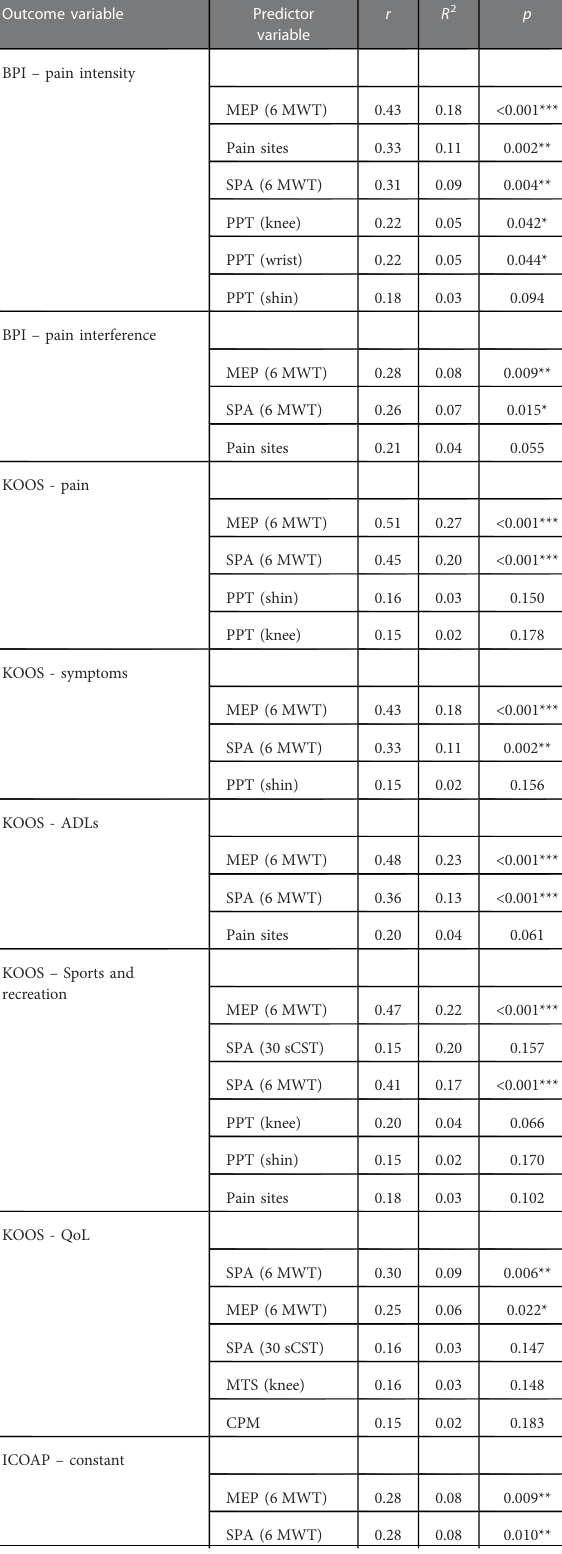
TABLE 3 Summary of sensitization measures a Sensitization measures